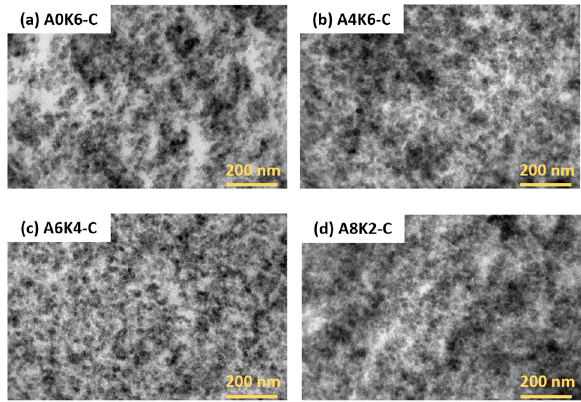
Figure 11. TEM images of four silica/NR composites.